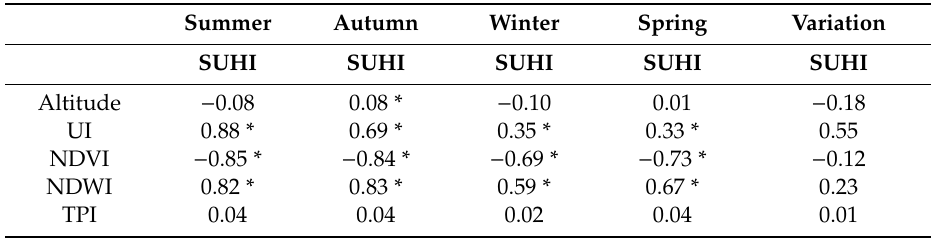
Table 4. Pearson’s correlation coefficient between SUHIs and altitude, UI, NDVI, Normalized Difference Water Index (NDWI) and Topographic Position Index (TPI) in different seasons.